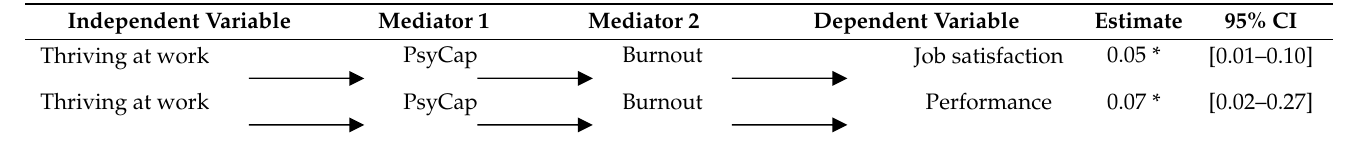
Table 3. Standardized indirect effects with bootstrapped 95% confidence intervals .